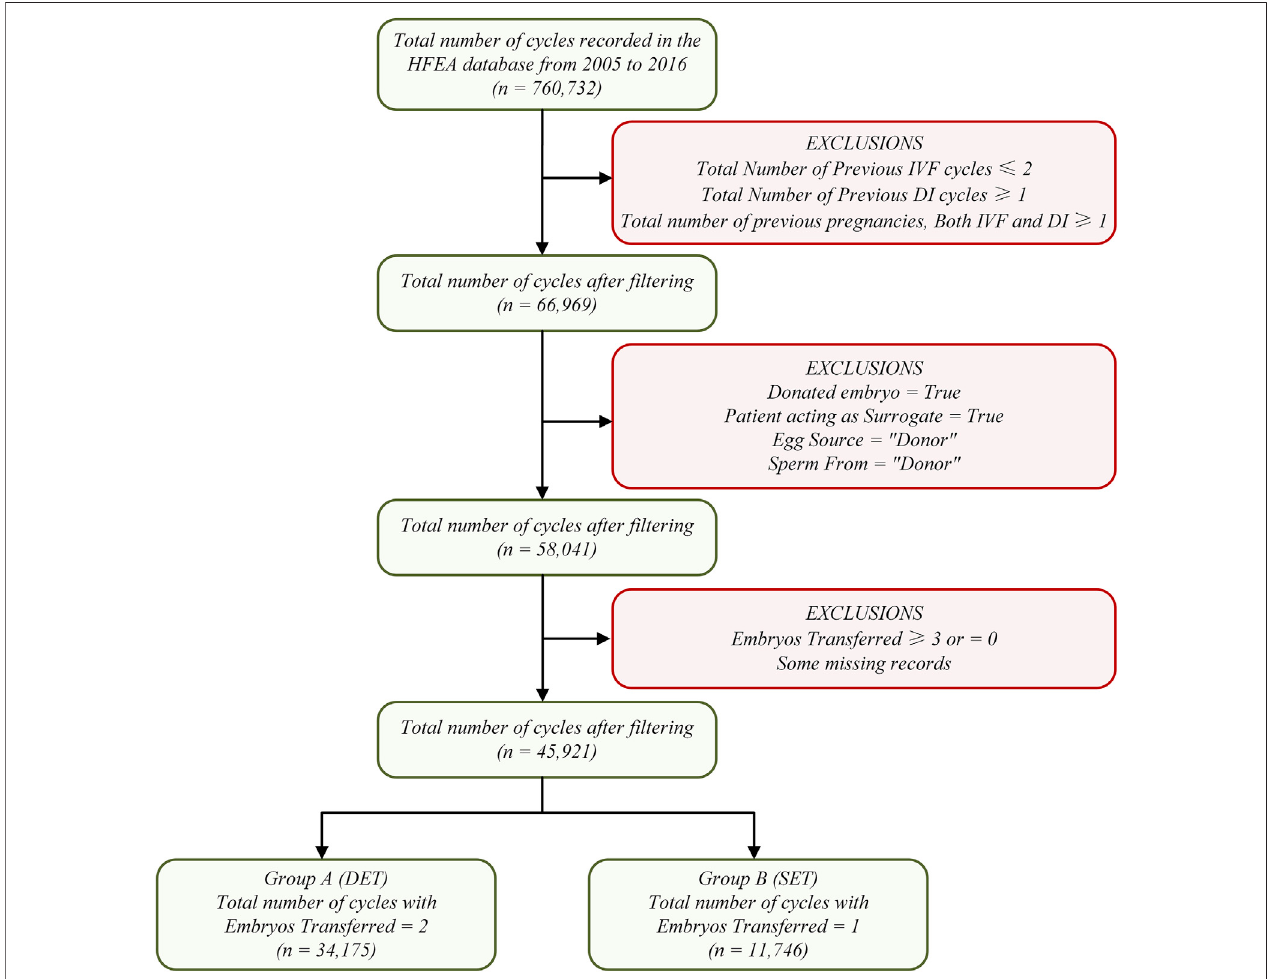
FIGURE 1 | Data set construction fl